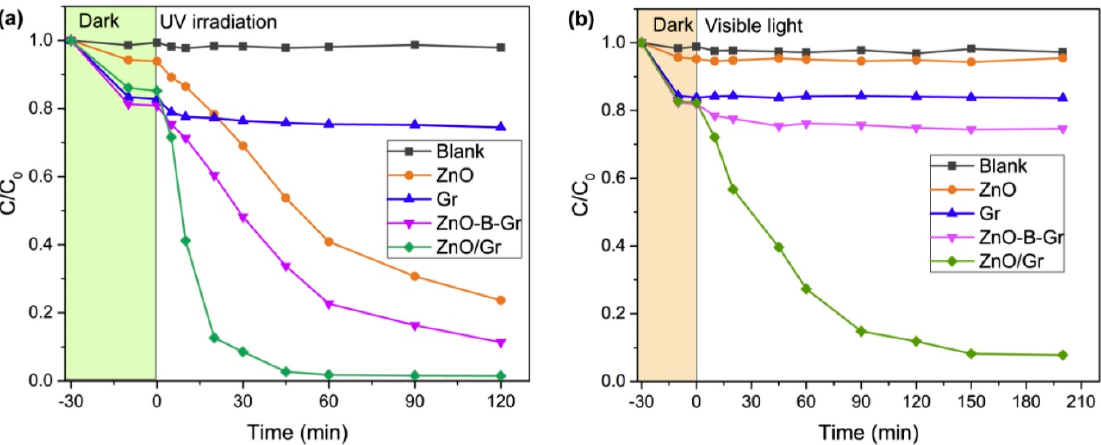
Figure 32. Photo-reduction of Cr(VI) under ( a ) UV and ( b ) visible lights. Reproduced with permission from [76].